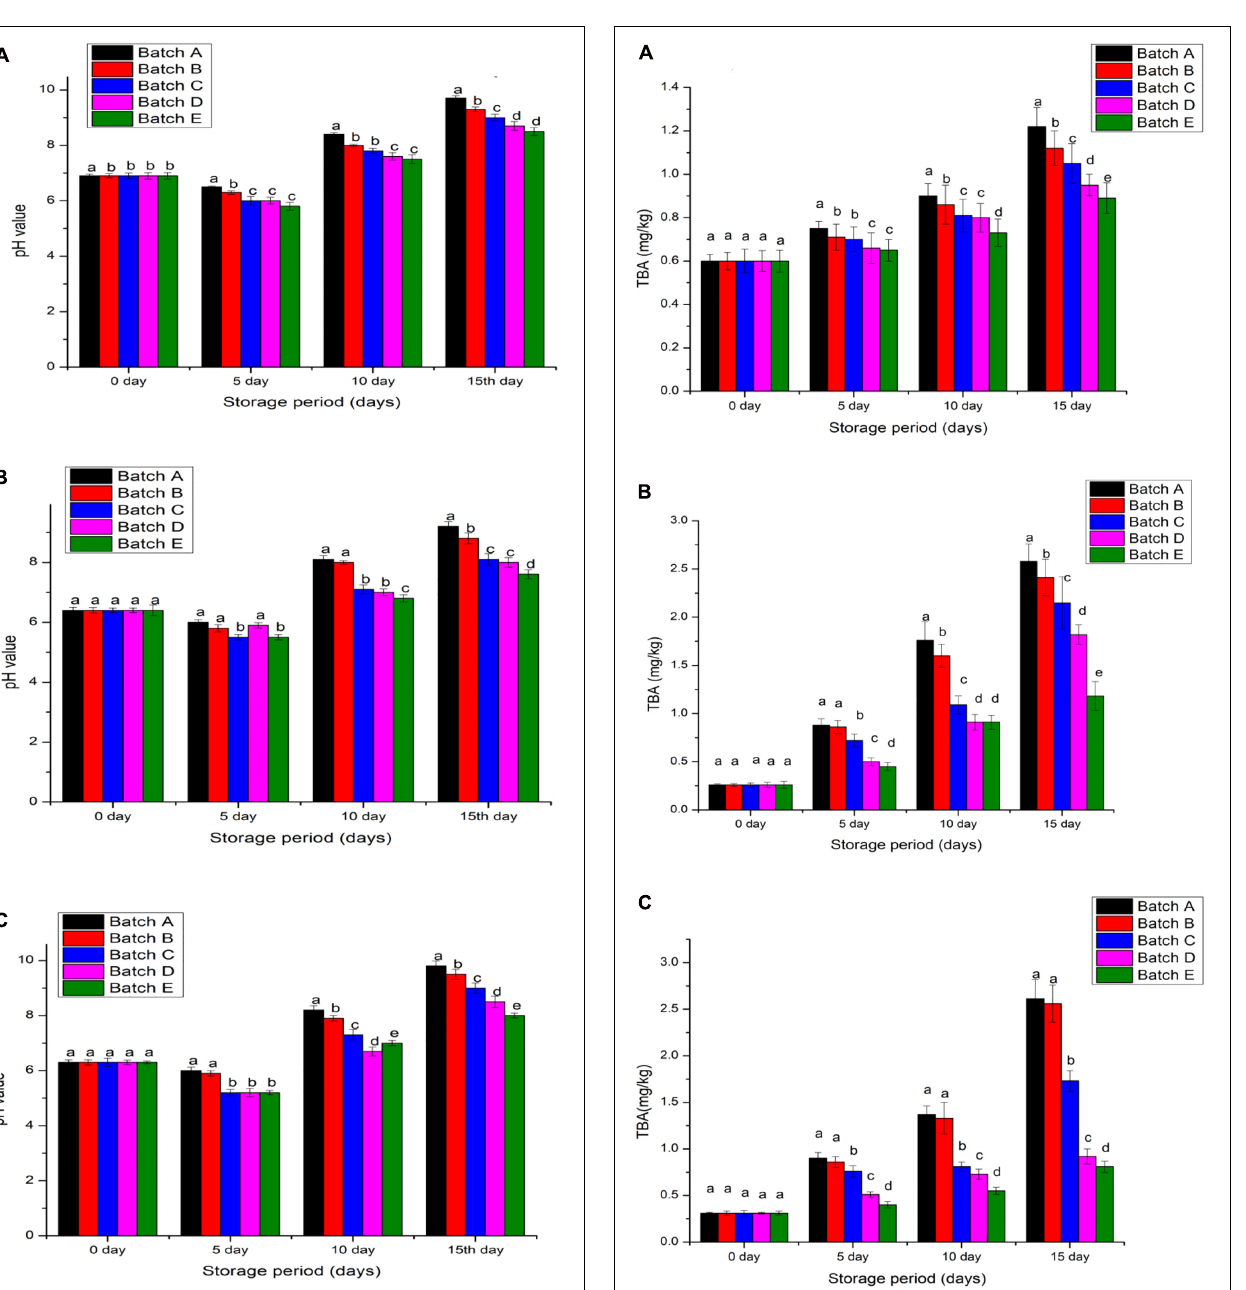
of pomfret, and hilsa fish below 6.3 log CFU/g, an acceptable food safety benchmark (Jeyakumari et al., 2016; Figure 7 ). It was difficult to sustain minimum viable counts in shrimp because on day 0, non-treated samples recorded 4.3 log CFU/g, acetic